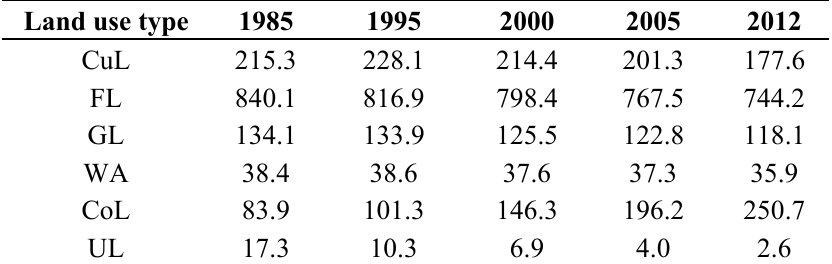
Table 1. The land use situations in Suxian District (km 2 ) by